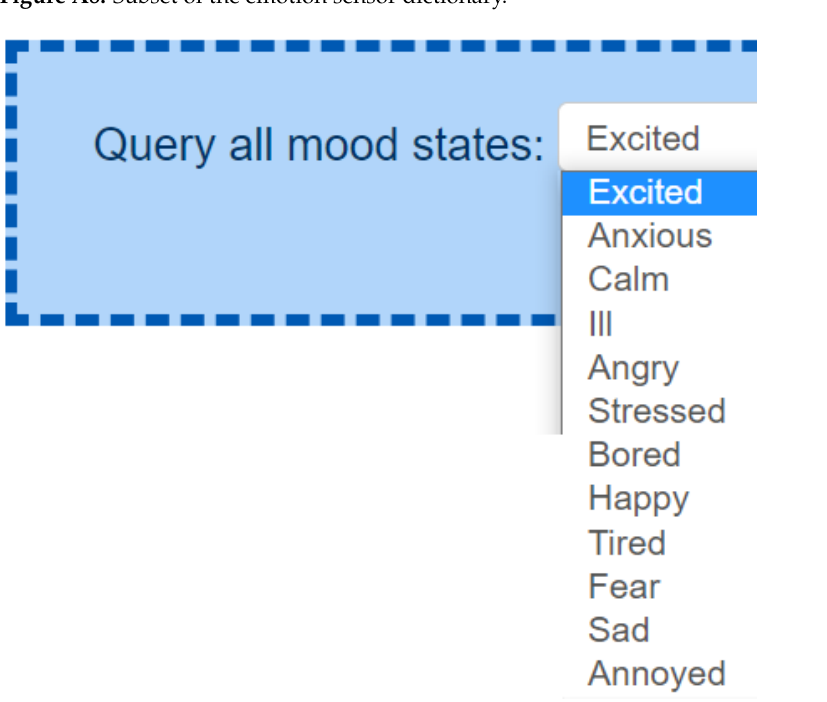
Figure A8. Subset of the emotion sensor dictionary.